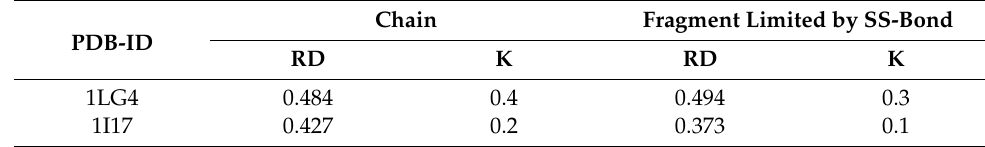
Table 4. The parameters describing the status of prion-like proteins.